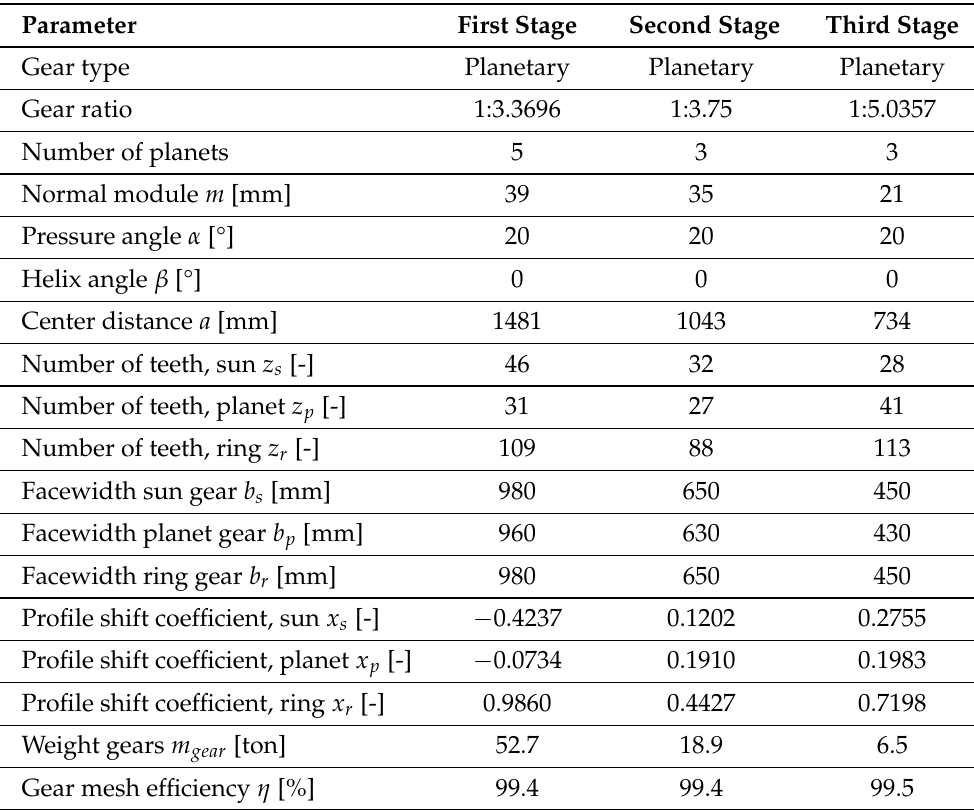
Table 5. Design specifications of MS gearbox based on three planetary stages